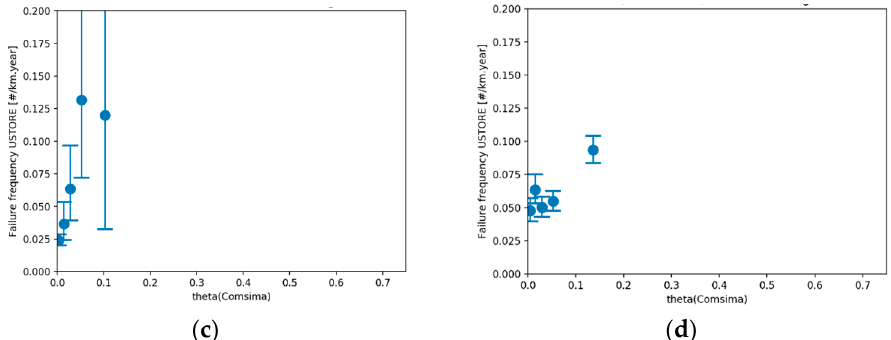
Figure 3. Comparison of Comsima results with failure data: ( a ) Failure parameter in Comsima versus the failure rate for PVC pipes; ( b ) failure parameter in Comsima versus the failure rate for AC pipes; ( c ) normalized joint rotation in Comsima versus the failure rate for PVC pipes; ( d ) normalized joint rotation in Comsima versus the failure rate for AC pipes.